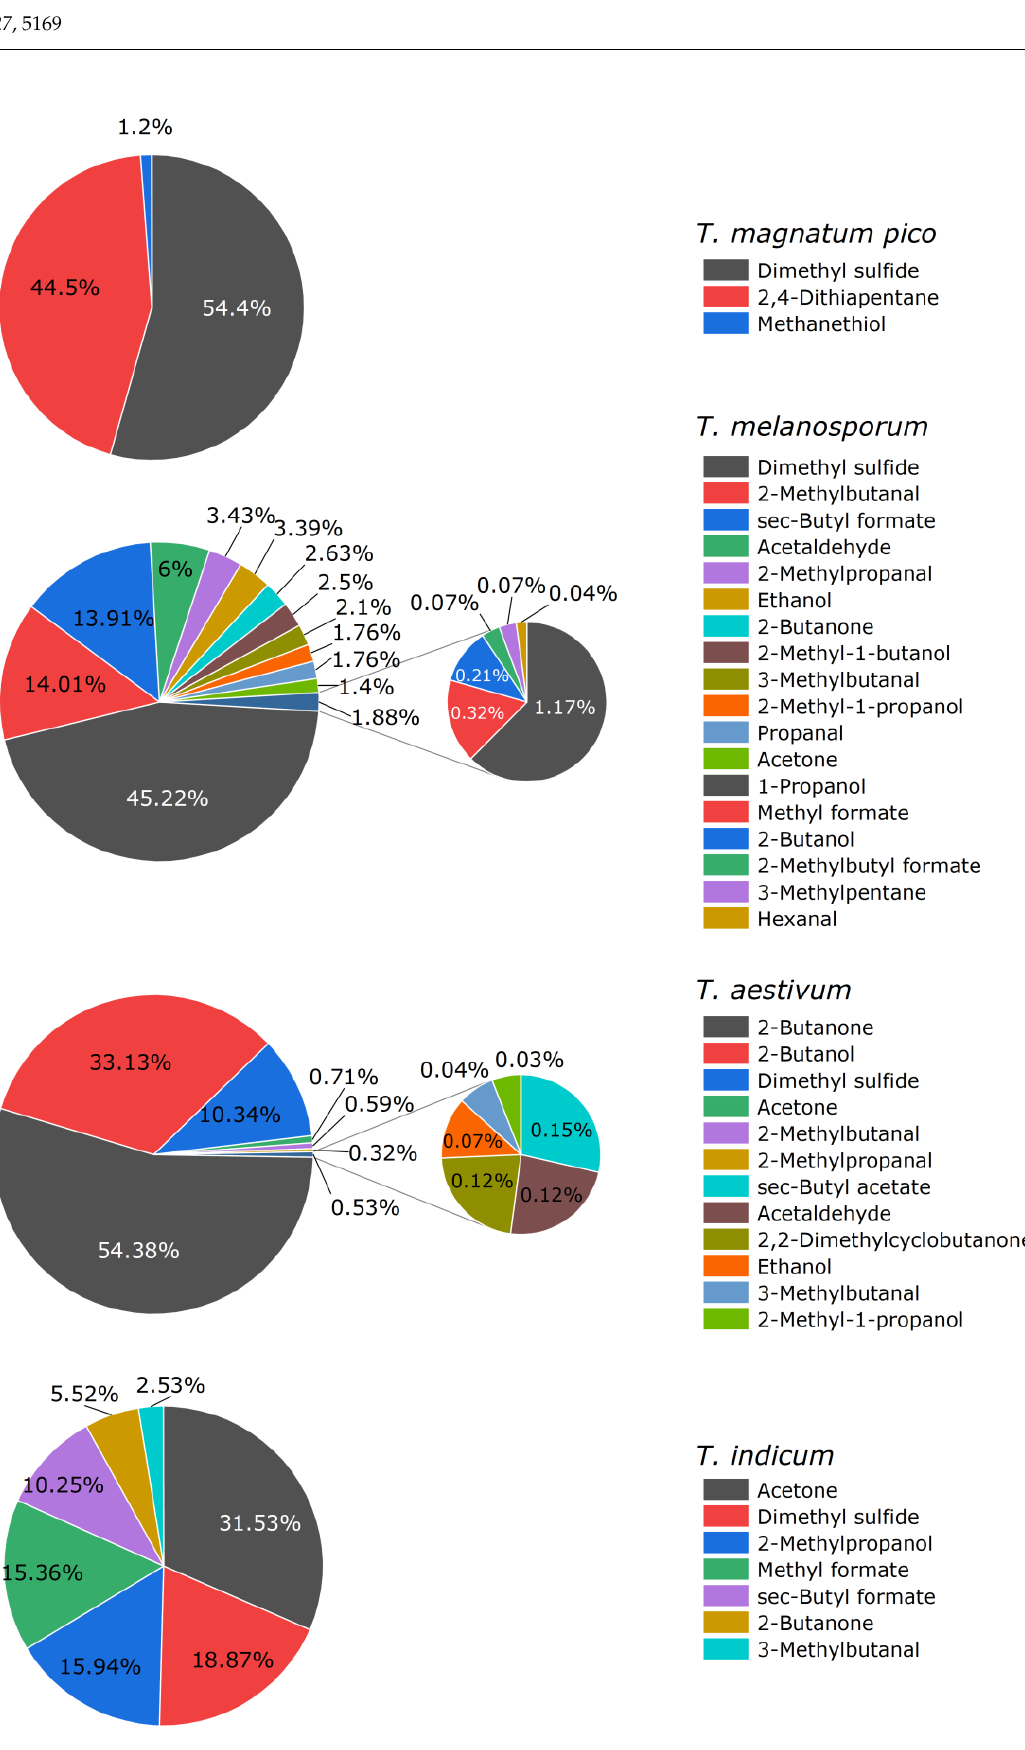
Figure 3. Aroma compounds of truffle samples as peak area percentage of the total ion chromatogram of SHS/GC-MS analyses.